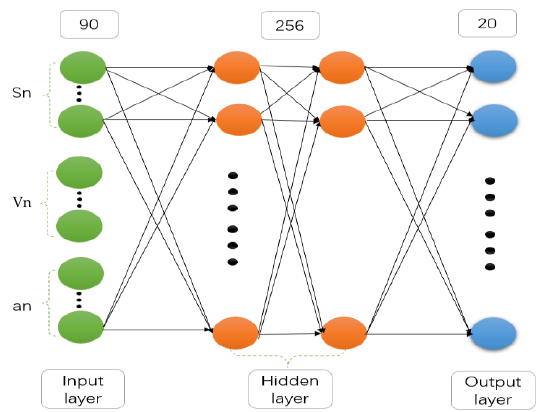
Figure 8. Deep learning network composition.